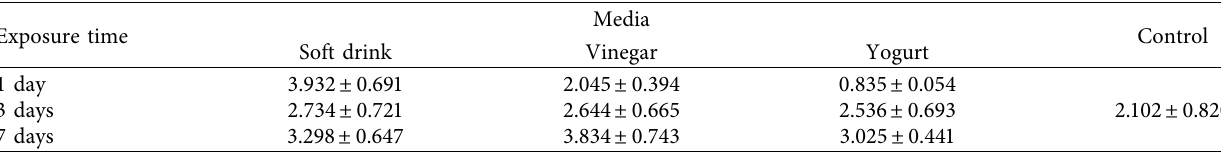
Table 3: Collagen crosslinking (mean SD) in the dentin of tooth samples after exposure to different media at variable times, including the control ±